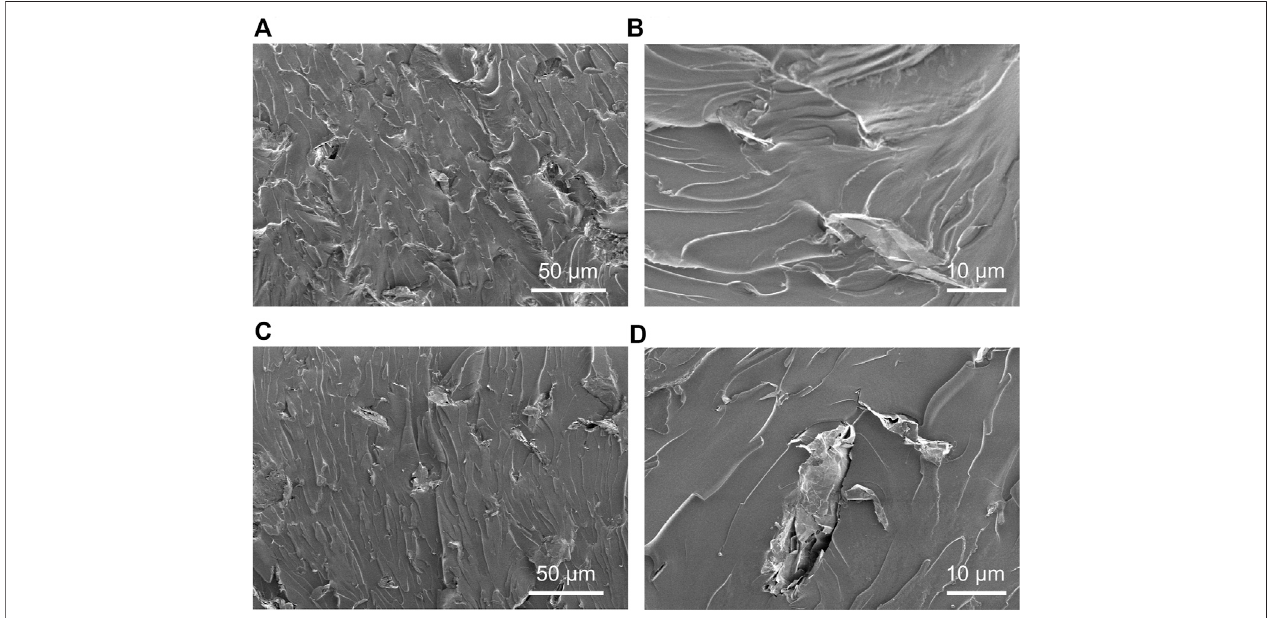
FIGURE 1 | SEM images of fracture surfaces of (A , B) GNPs fi rst mixed with epoxy resin followed by adding hardener and (C , D) GNPs fi rst mixed with hardener followed by adding epoxy resin.